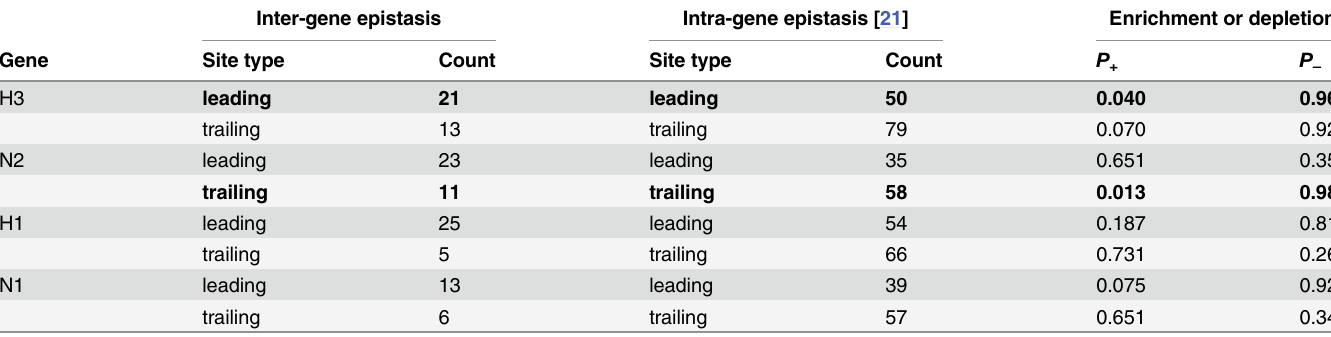
Table 2. Comparisons of sets of sites evolving under inter-gene vs. intra-gene